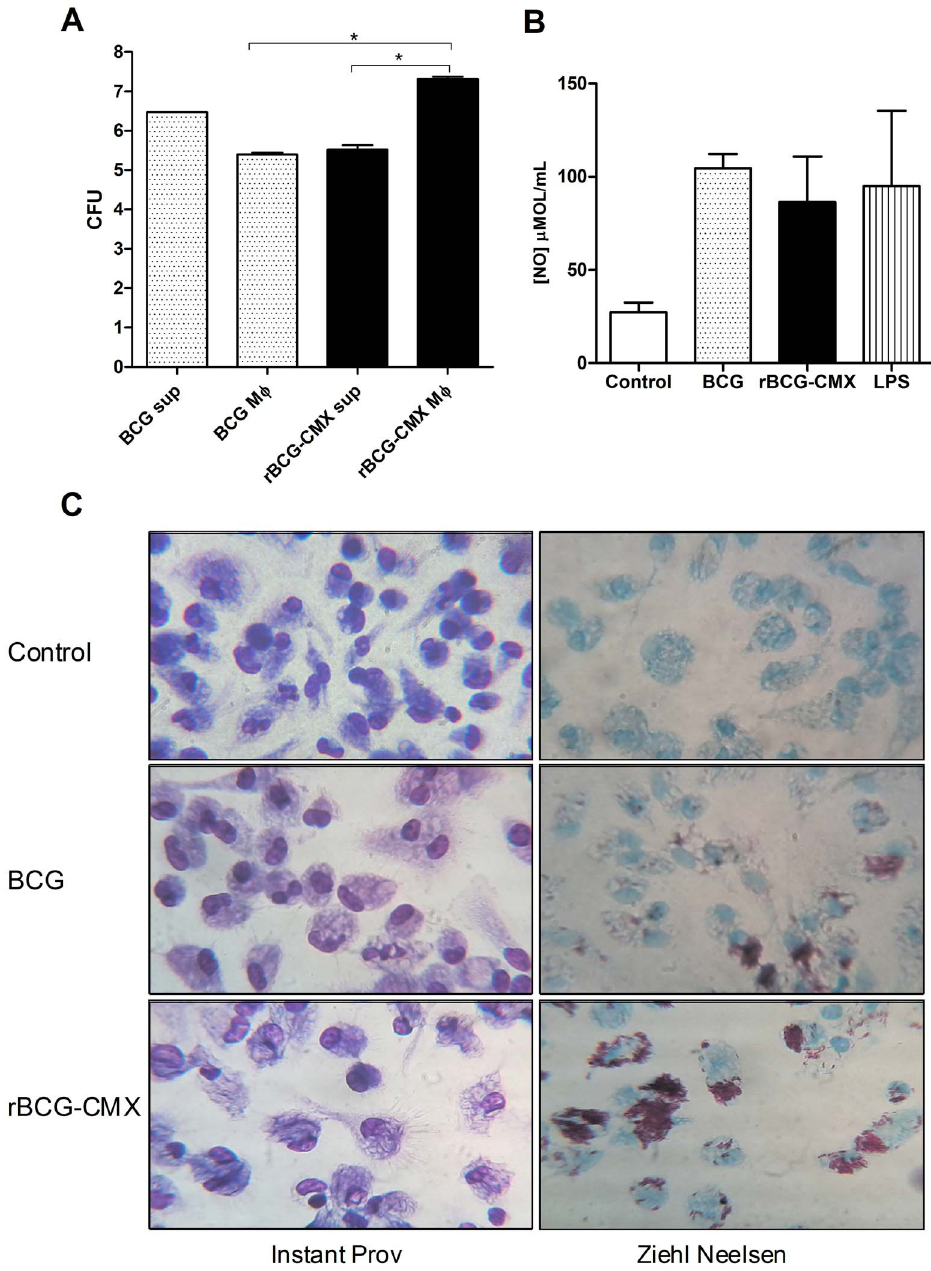
Figure 3. Levels of phagocytosis by peritoneal macrophages of BCG and rBCG-CMX after infection (MOI=10). (A) Macrophages were infected with BCG or rBCG-CMX and the bacterial load in both the supernatant (sup) and inside the macrophages (M w ) were determined. The